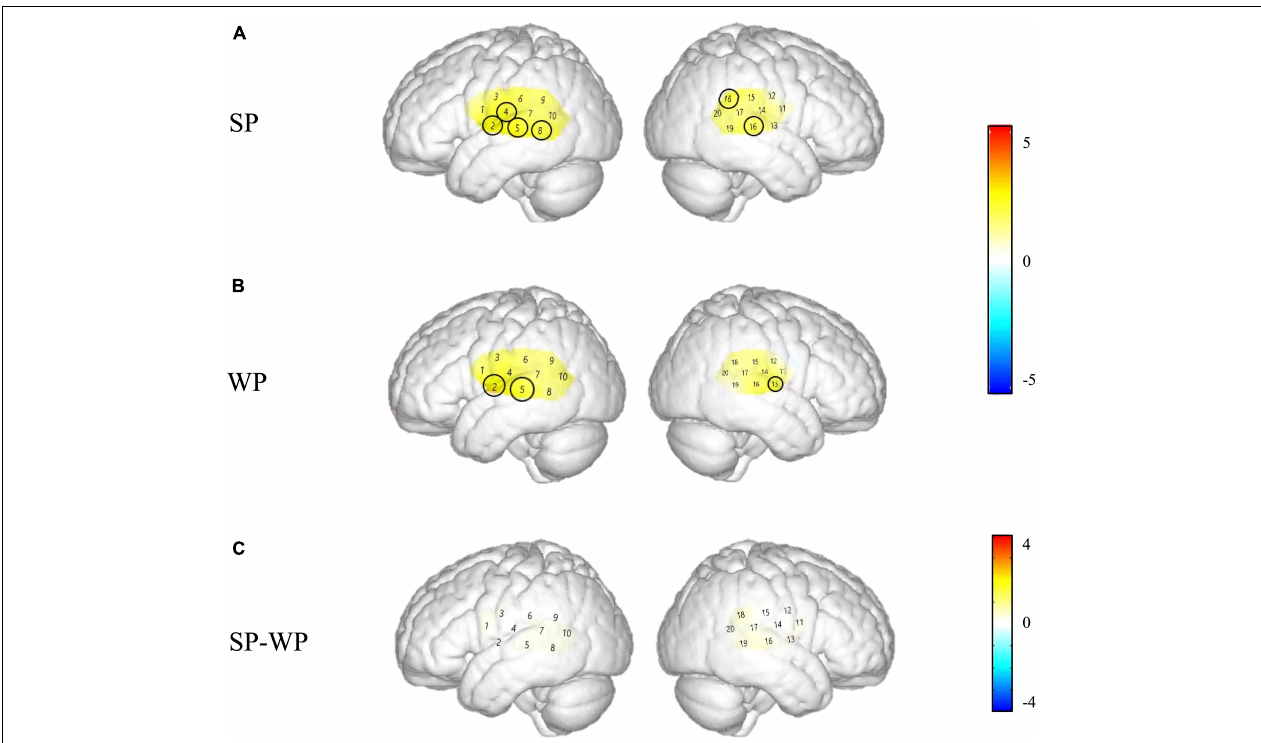
FIGURE 8 | Cortical activation maps of the cochlear implantation (CI) group on the normalized brain surface. The color scales represent the T values, with statistically significant activated channels circled in black [ p FRD - cor < 0.05]. (A,B) Lateral views of significantly activated channels under strong-prosodic (SP) and weak-prosodic (WP) conditions contrasted against silence, respectively. (C) Lateral views of significantly activated channels by contrasting between conditions, indicating the stronger activated neural areas driven by the SP features in SP sentences.